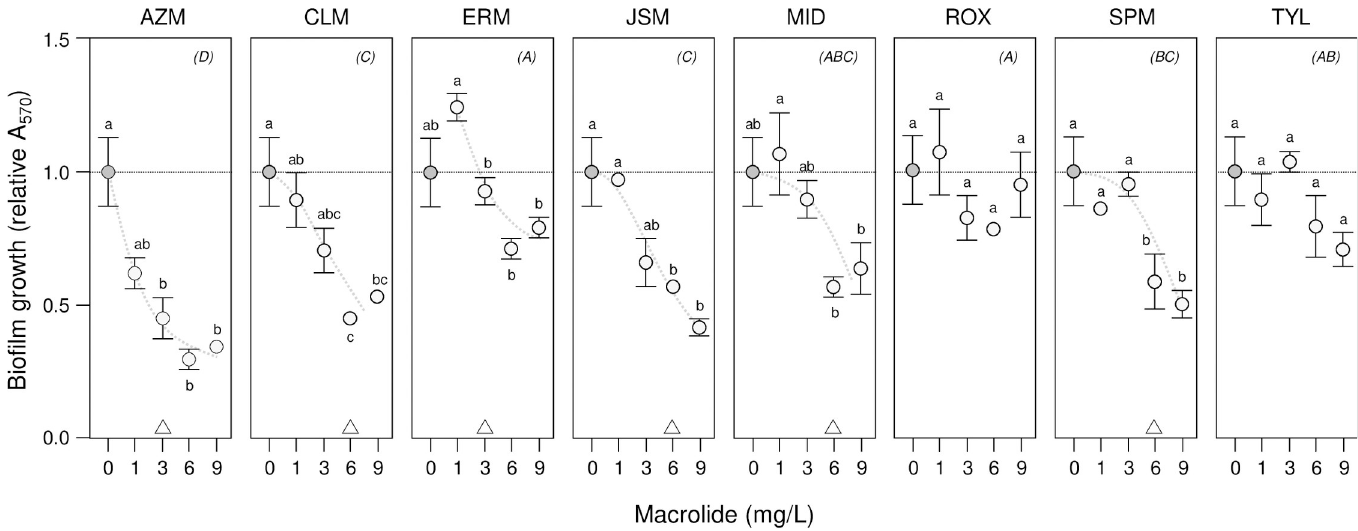
Fig 2. MTT assays of K . pneumonia biofilm growth show inhibition by macrolides. The inhibition of K . pneumonia ATCC 10031 biofilm growth by eight macrolides was investigated by biofilm assays using the metabolic indicator dye MTT with absorbance (A 570 ) measurements after 24 h incubation. Mean relative A 570 ± SE ( n = 3) is shown, with the no-macrolide (control) treatment indicated by dark circles and 1–9 mg/L macrolide treatments by light circles (trends are suggested by dashed curves). Means not connected by the same letters within panels are significantly different (LSMeans Differences Tukey HSD, alpha = 0.05 for individual macrolide mixed-effects models). Triangles at the bottom of panels indicate biofilm minimum inhibitory concentrations (MIC) where relative A 570 was first significantly reduced by macrolide treatment. Macrolides not connected by the same letters indicated in parentheses in the top-right of each panel are significantly different (LSMeans Differences Tukey HSD, alpha = 0.05 for combined macrolide mixed-effects model of relative OD 570 ; note no significant differences for ROX and TYL).